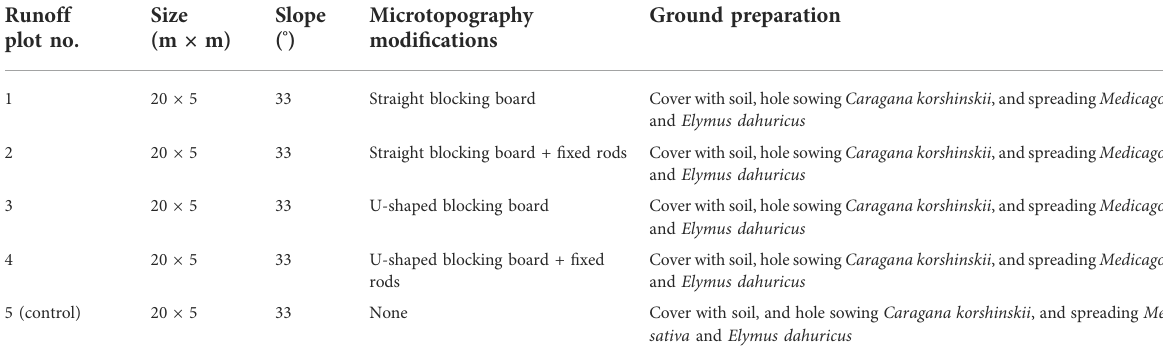
TABLE 1 Slope microtopography modi fi cations in the fi ve plots analyzed in the present study. Runoff plot